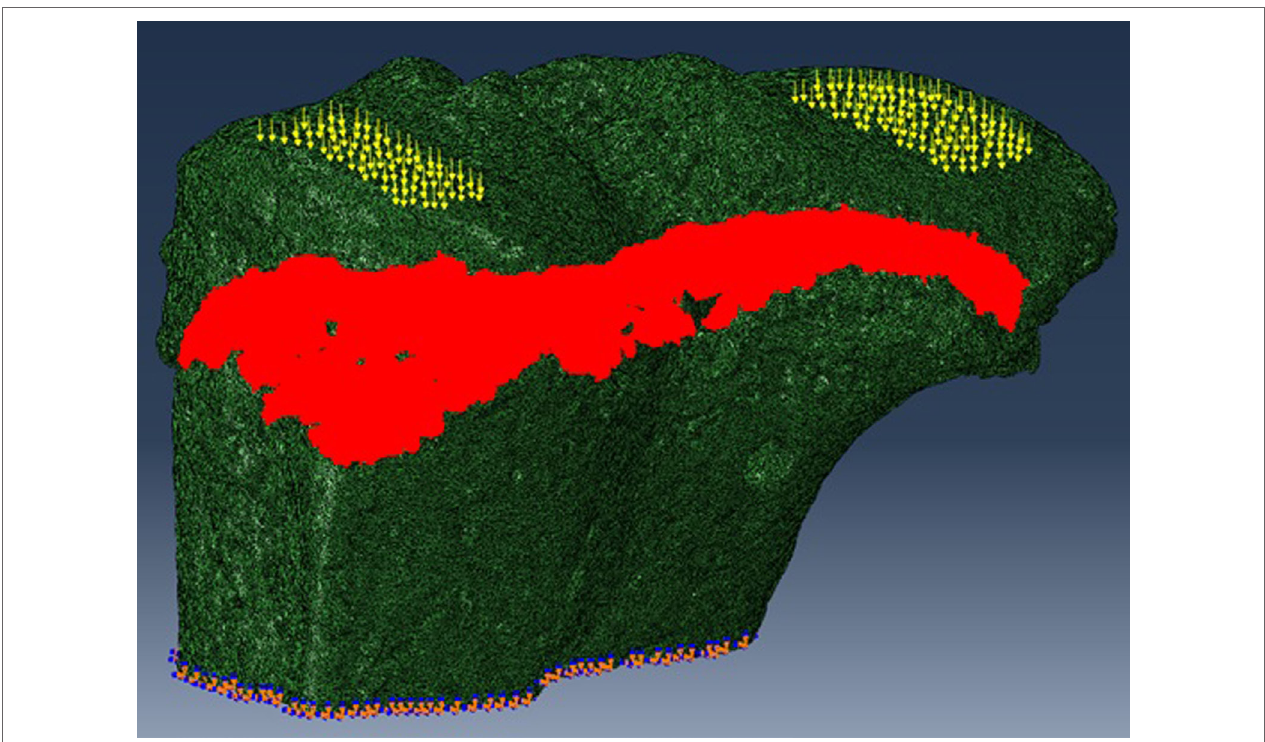
FigUre 3 | For finite element (FE) modeling, FE computations were carried out to simulate static compressive tests (sustained loading). The nodes at the bottom of the tibia have their vertical displacements fixed and certain rotations are restrained to block rigid body motion. At the top, equal loads of three times body weight (~1 N) were applied in the medial and lateral aspects of the tibia.